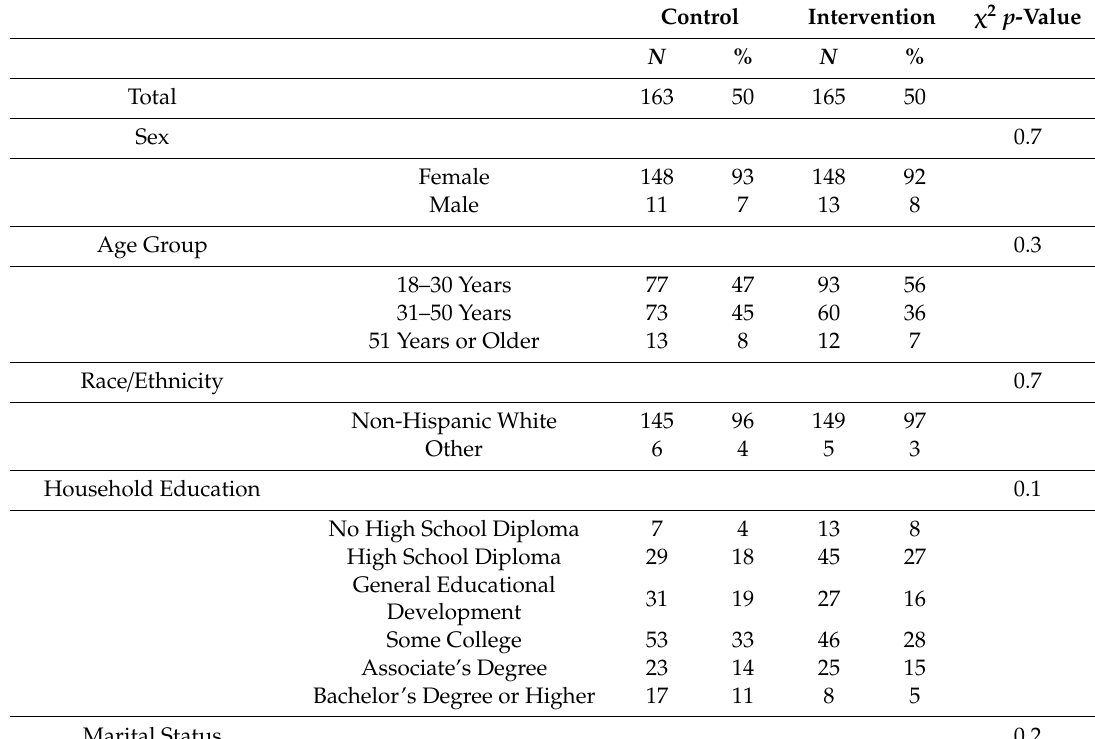
Table 1. Comparison of baseline sociodemographic characteristics by treatment group of Indiana SNAP-Ed participants among households with children using Chi-Square